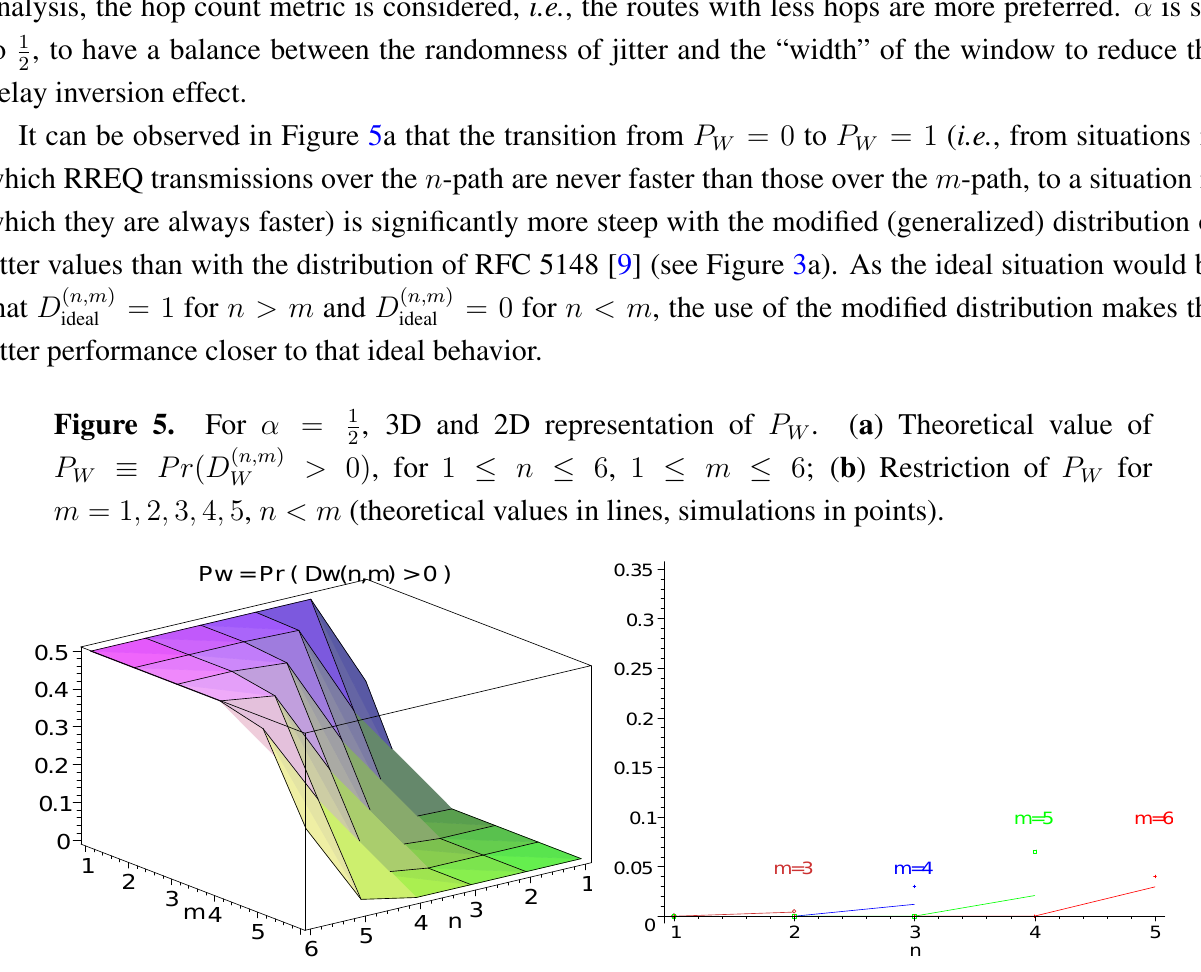
for different combinations of path lengths n and m . In the W